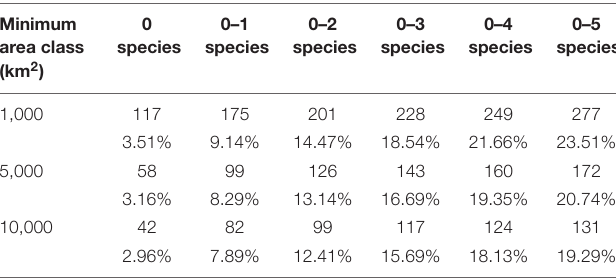
TABLE 1 | The change in number of ecoregions (top row) and percentage land surface area (second row) that could potentially be conserved with the reintroduction of extant species that have been locally extirpated onto land where HF ≤